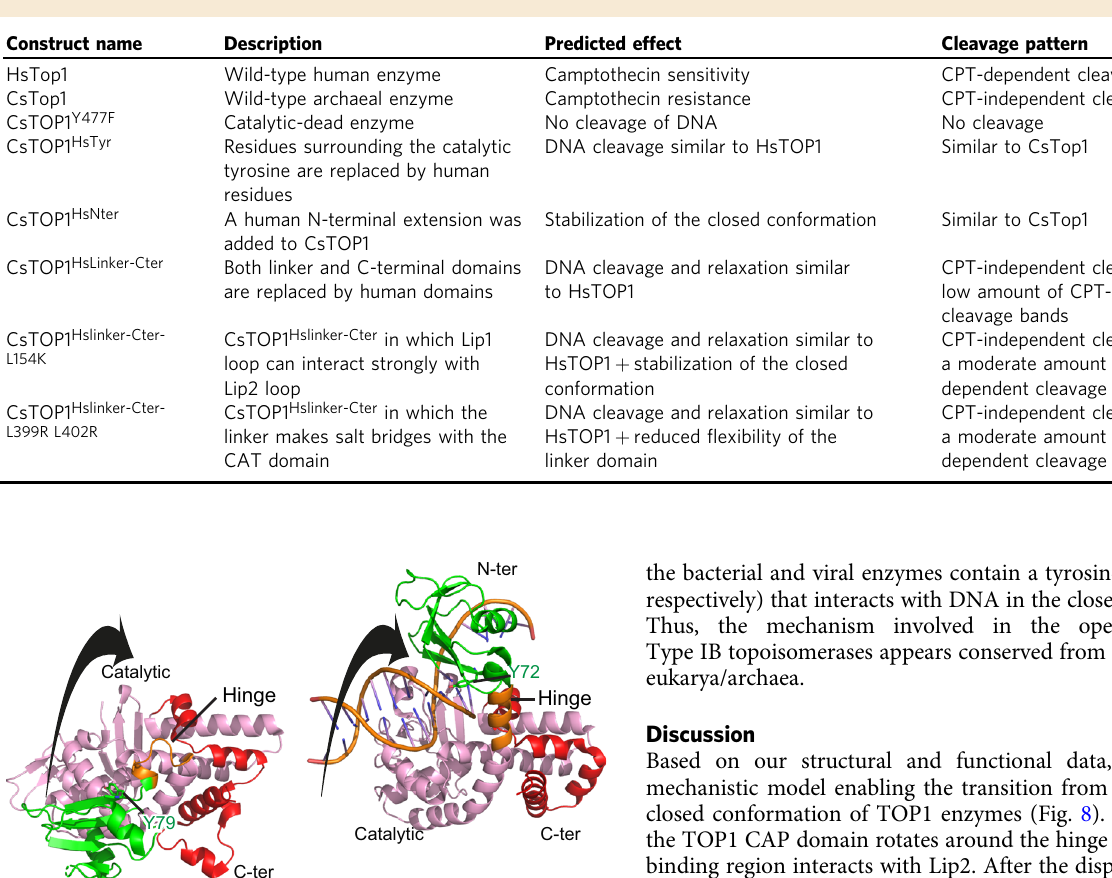
Table 1 CsTOP1 constructs used for CPT sensitivity assays.